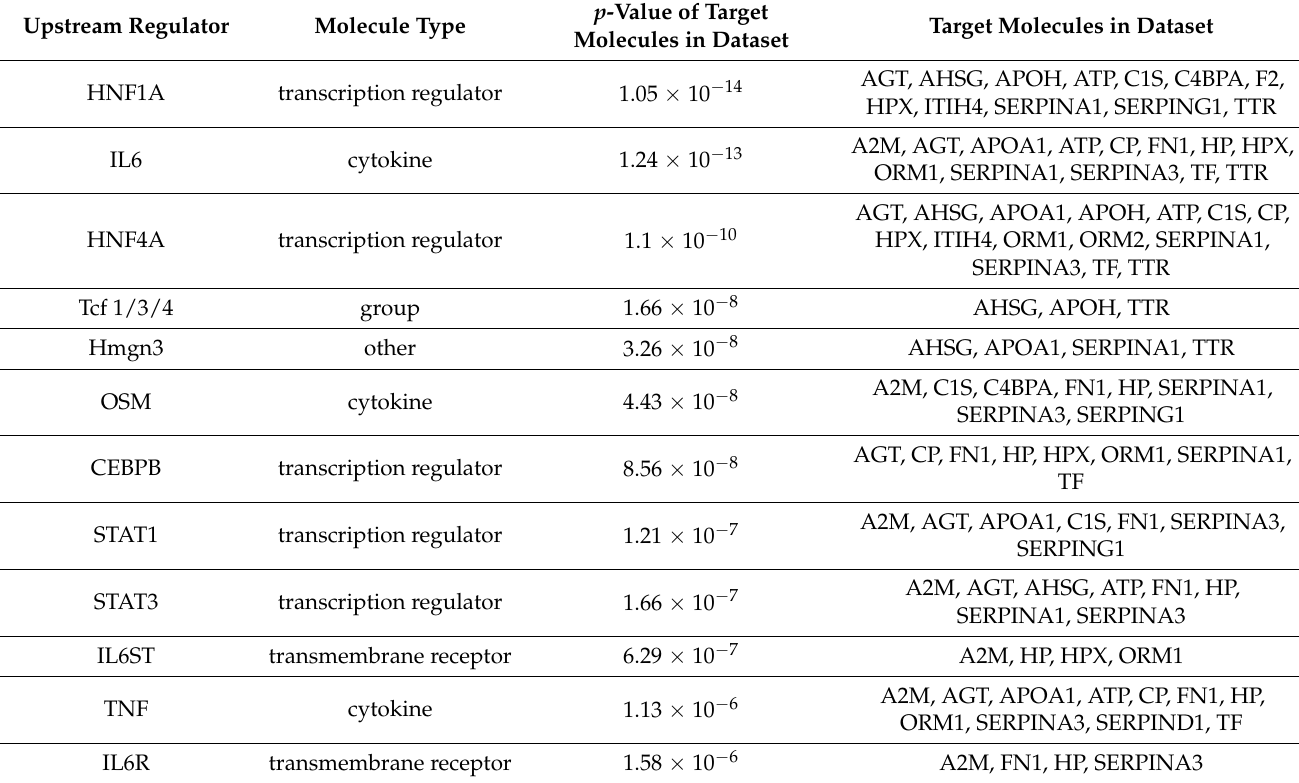
Figure 13. Statistical significance levels of differential activation of canonical pathways among healthy vs. symptomatic COVID-19 patients. Table 3. Top 12 upstream regulators (acute-phase response signaling).